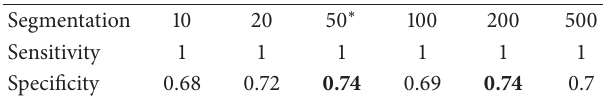
Table 2: Rub-impact detection rate of different segmentation